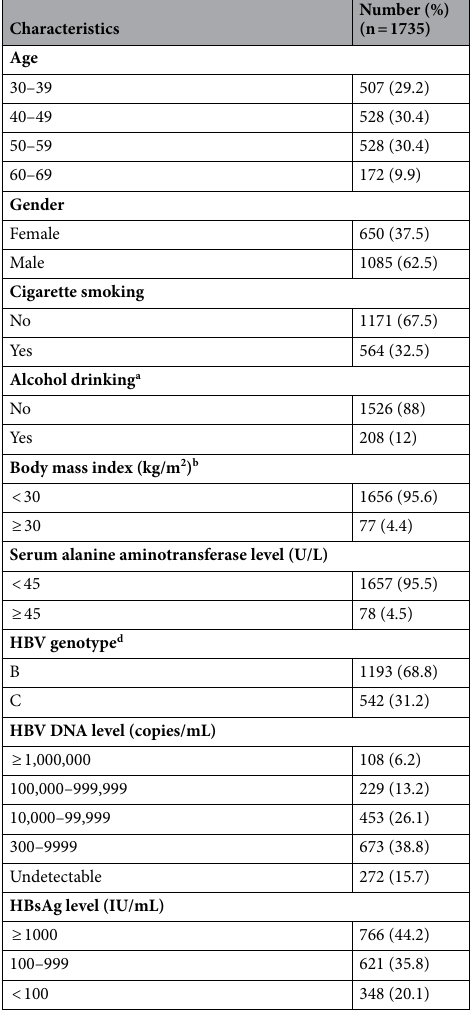
Table 1. Baseline characteristics of 1735 HBeAg-seronegative patients with genotype B or C chronic hepatitis B virus infection in the REVEAL-HBV cohort.